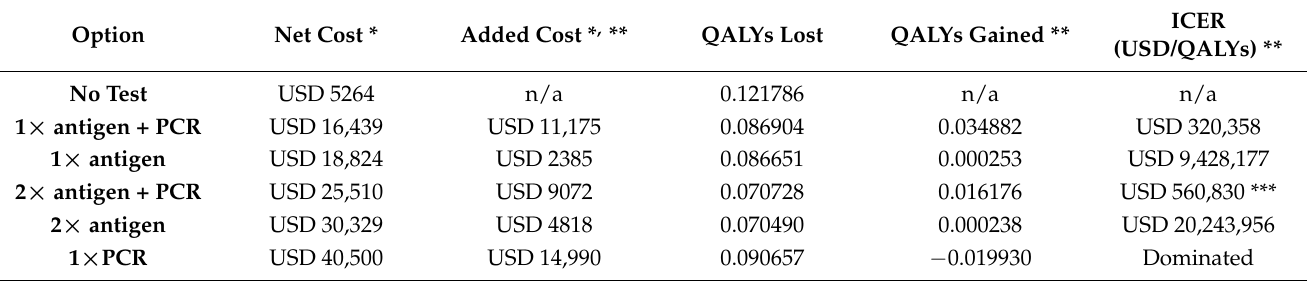
Table 2. Cost-effectiveness of testing strategies from a societal perspective, per thousand